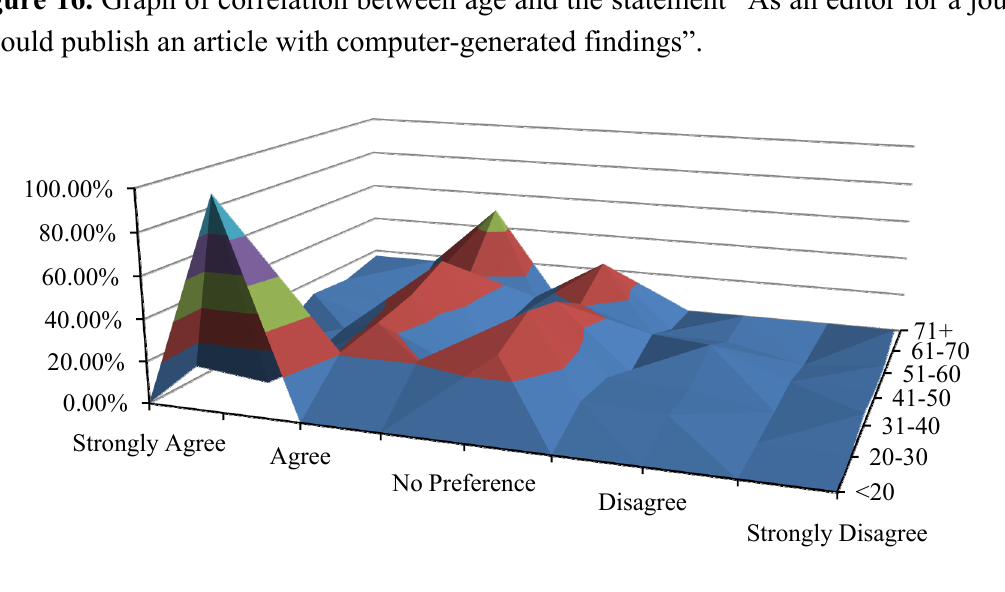
Table 16. Correlation between years of experience and the statement “As an editor for a journal, I would publish an article with computer-generated